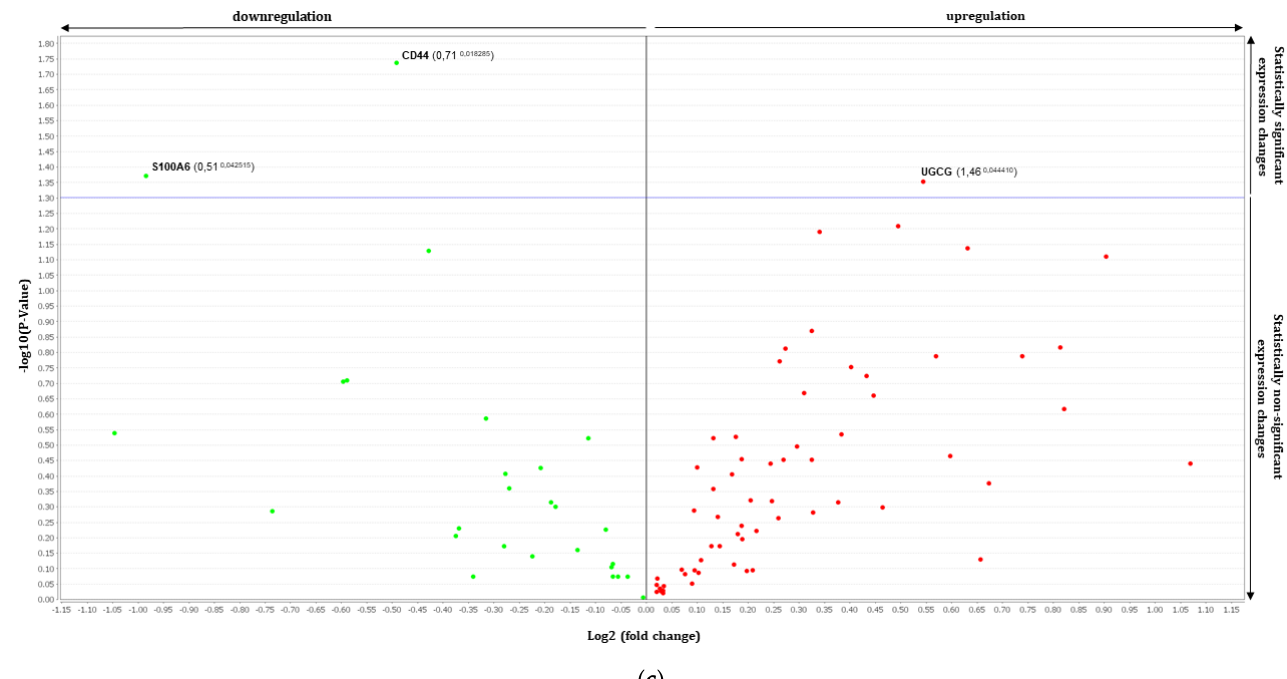
Figure 2. Volcano plots in analyzing differential gene expressions comparing between ( a ) control RHE and Th2 induced- RHE, ( b ) Th2 induced-RHE and FV treated Th2 induced-RHE and ( c ) Th2 induced-RHE and UP treated Th2 induced-RHE. Fold change boundary: 1 and p -value boundary: 0.05.